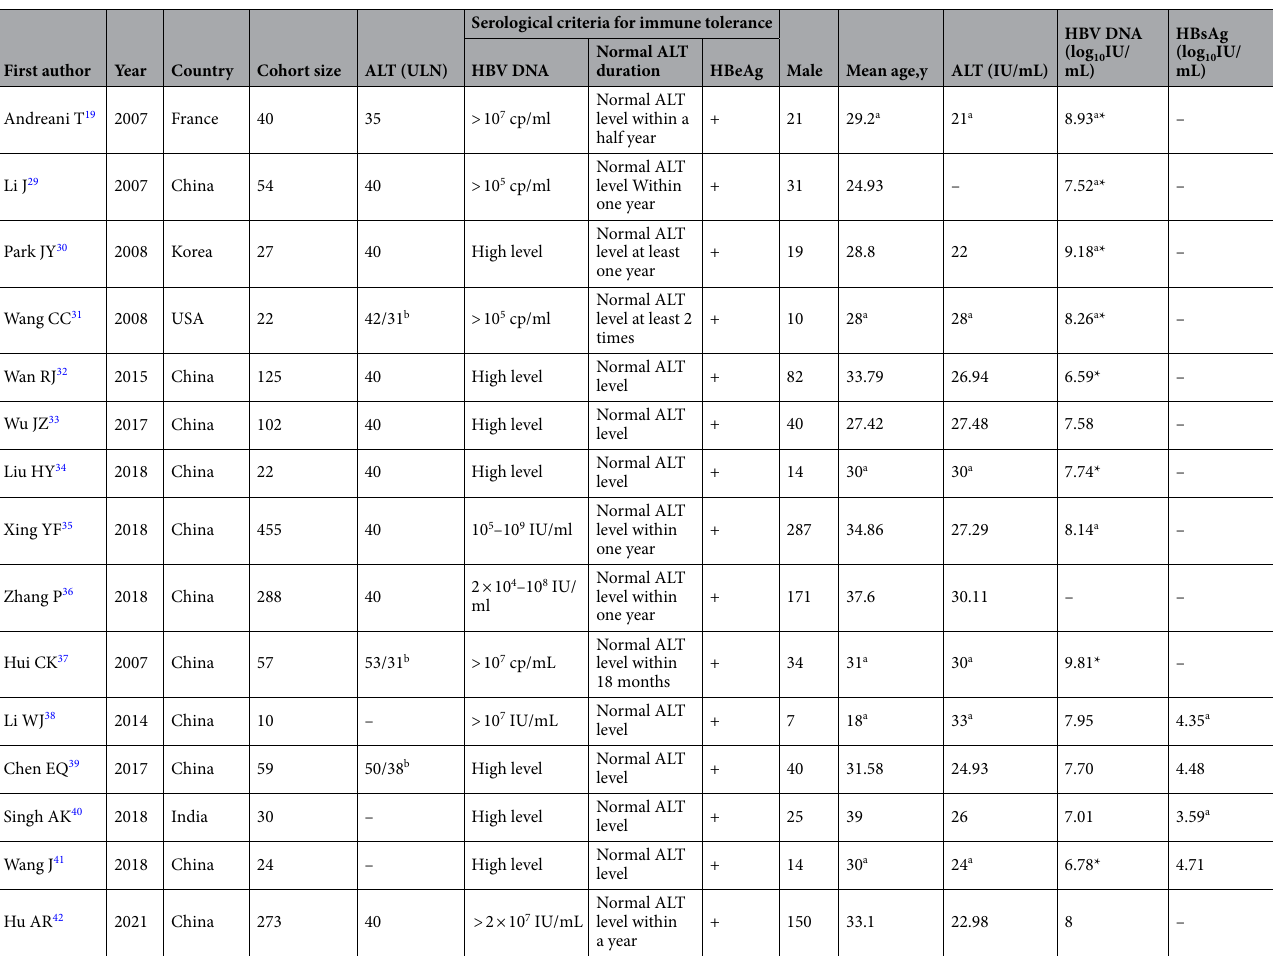
Table 1. Characteristics of the included studies and patients. a Median; b High value for male and low value for female; *log 10 copy/mL; USA, the United States of America.